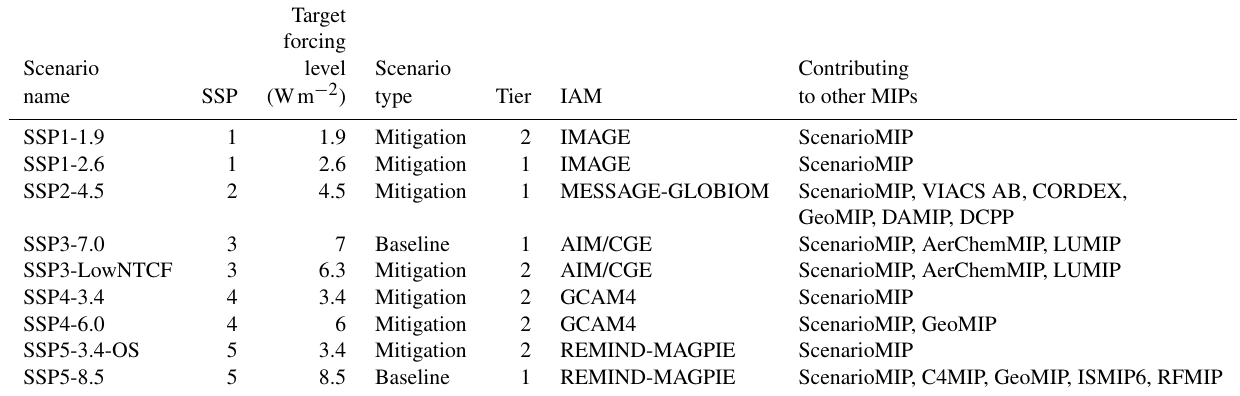
Table 1. All scenarios and associated attributes used in the ScenarioMIP experiment ensemble.